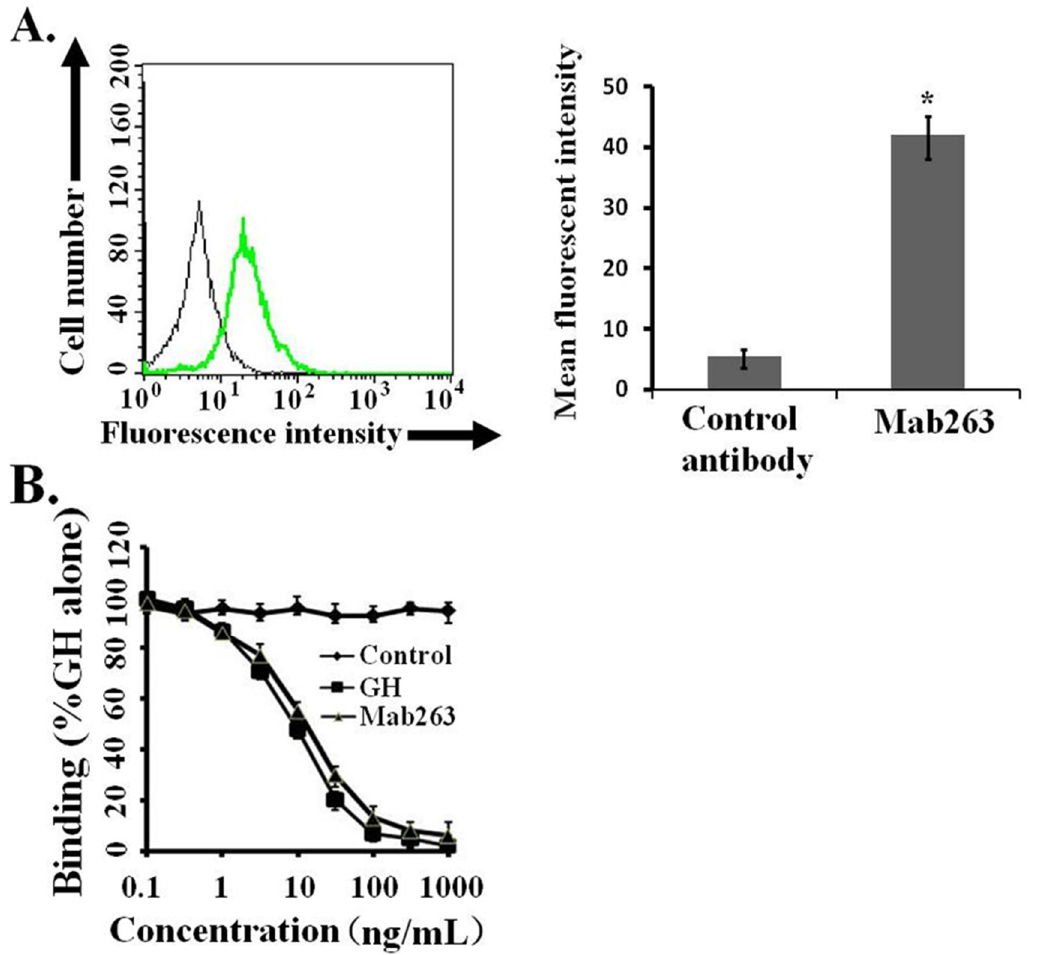
the total phosphorylated tyrosine, was chosen to assess the STAT5 and STAT1 phosphorylation again. No tyrosine phosphorylation on STAT5 was detected (data not shown), suggesting that Mab263 does not activate STAT5 and STAT1 under our current experimental conditions. Figure 1. Monoclonal antibody 263 (Mab263) specifically binds to mouse growth hormone receptor (mGHR) expressed on the mouse GHR cell model. ( A ) Binding of fluorescein isothiocyanate-Mab263 (FITC-Mab263) to 3T3-F442A cells. The cells were pre-treated as described in the Materials and Methods. The cells were then incubated with FITC-Mab263 (green line, MFI (mean fluorescence intensity): 41.96) or FITC-control antibody (black line, MFI: 5.60) for 1 h in the dark at 4 °C. The cells were then washed, resuspended in 0.5 mL fluorescence-activated cell sorting (FACS) buffer and analyzed using a FACS Calibur Flow Cytometer. ( Right ) The corresponding histogram of the data of three separate FACS analyses. Data are shown as the mean ± SE. * p < 0.05 compared with the control value; and ( B ) Mab263 competes with GH for binding to GHR. The 3T3-F442A cells were pre-treated as described in the Materials and Methods. The cells were incubated with the indicated amounts of FITC-GH in the absence or presence of various concentrations of unlabeled GH, Mab263 or control antibody. After washing, the cells were resuspended in 0.5 mL FACS buffer and analyzed by flow cytometry. The data shown are the mean ± SE from three independent